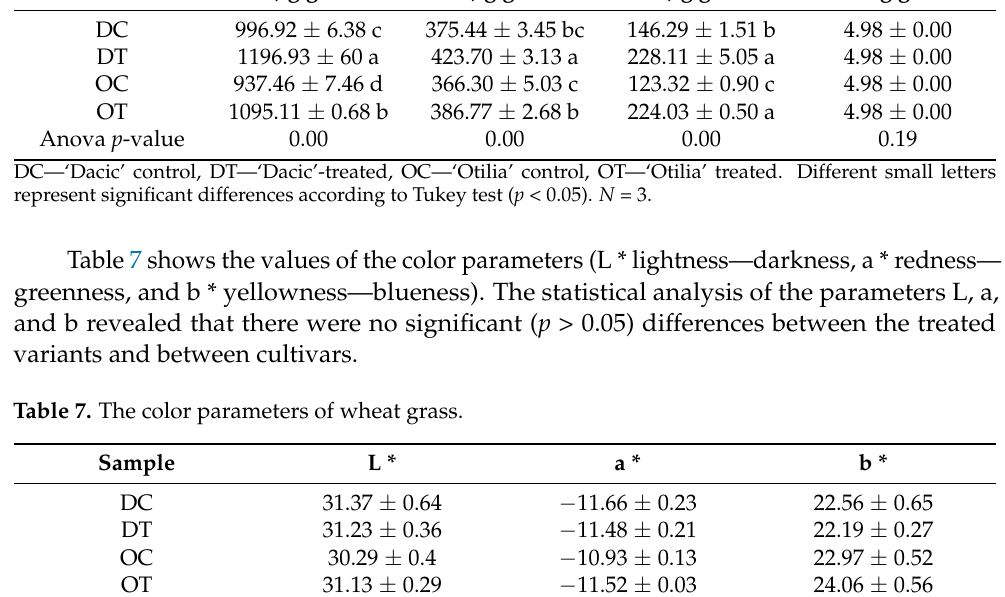
Table 6. The content of assimilatory pigments and soluble proteins in wheat grass. Samples